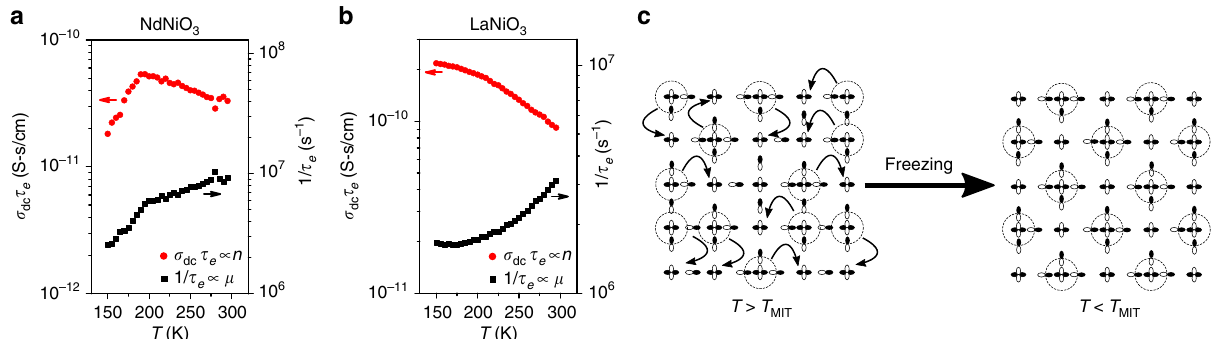
) multiplied by the carrier hopping time ( τ e ) (red circles, Fig. 4 A sketch of the proposed bipolaronic condensation mechanism. a The dc conductivity ( σ ′ dc left axis) as well as the inverse hopping time (black squares, right axis) for NdNiO 3 as a function of temperature. The latter is proportional to the product of the carrier concentration ( n ) while the former is proportional to mobility ( μ ). b The same for LaNiO 3 . c A schematic sketch (projected in two dimensions) of the metal – insulator transition in NdNiO 3 in which a disordered liquid of polaronic distortions in the metallic phase freezes into a charge-ordered phase of lattice bipolarons. Circles denote double ligand holes, i.e., d 8 L 2 , where two holes occupy the molecular orbitals on the surrounding O 6 octahedra. Here, we only show the 3 d x 2 (cid:3) y 2 Ni orbital and surrounding O 2 p σ orbitals for